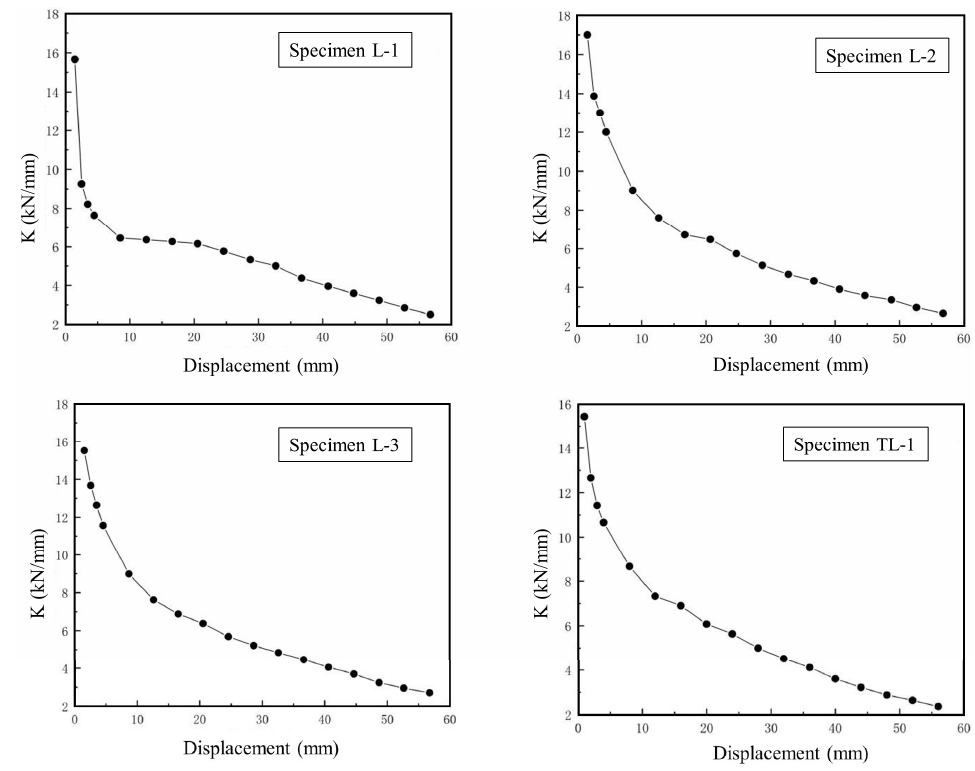
Figure 11. The stiffness degradation of the specimen.